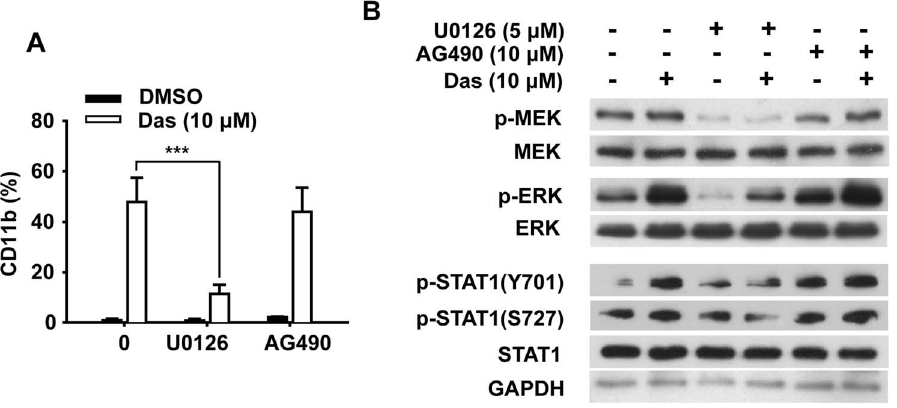
Figure 5. Dasatinib-induced HL60 cells differentiation could not be abrogated by JAK inhibitor AG490. HL60 cells were treated with dasatinib (10 m M) in the presence of U0126 (5 m M) or AG490 (10 m M) for 72 h. (A) The percentages of CD11b expression cells were determined as described. Data presented are the mean 6 SD of three independent experiments. *** P , .001 (B) The expression of p-MEK, p-ERK, p-STAT1(Y701) and p-STAT1(S727) as well as their total proteins were analyzed by Western blotting. The experiments were repeated three times and the data show the representative results.